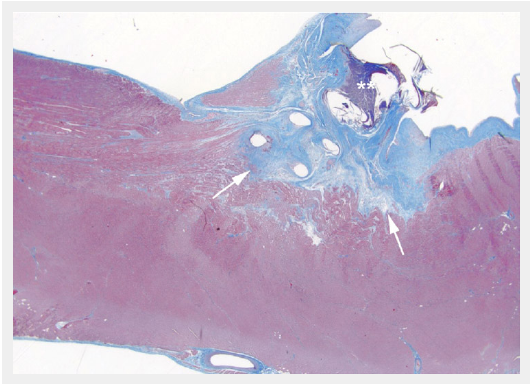
Histological specimen of the heart muscle obtained in a pig with implanted conventional pacemaker lead after imaging with a high power RF MRI scan. Tissue damage due to heating around the lead tip is visible (arrow). Note: The location of the lead tip is highlighted by